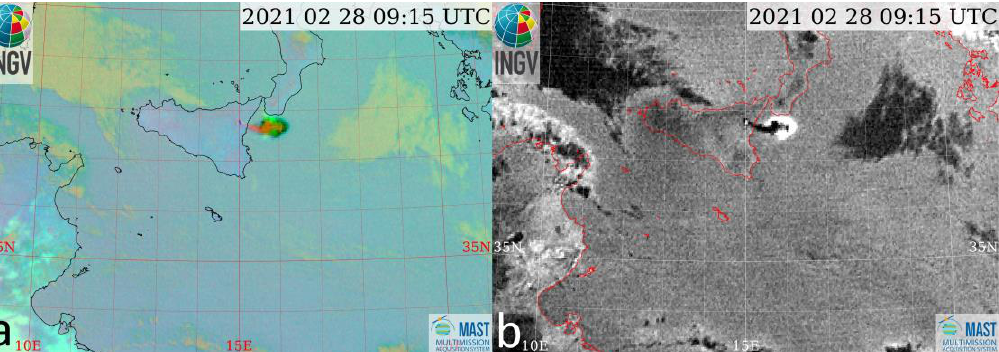
Figure 5. SEVIRI image collected at 09:15 UTC, 28 February 2021. ( a ) RGB composition (R: BT 12.0 − BT 10.8 ; G: BT 10.8 −BT 8.7 ; B: BT 10.8 ). ( b ) Brightness Temperature Differences (BTD = BT 10.8 -BT 12 ).